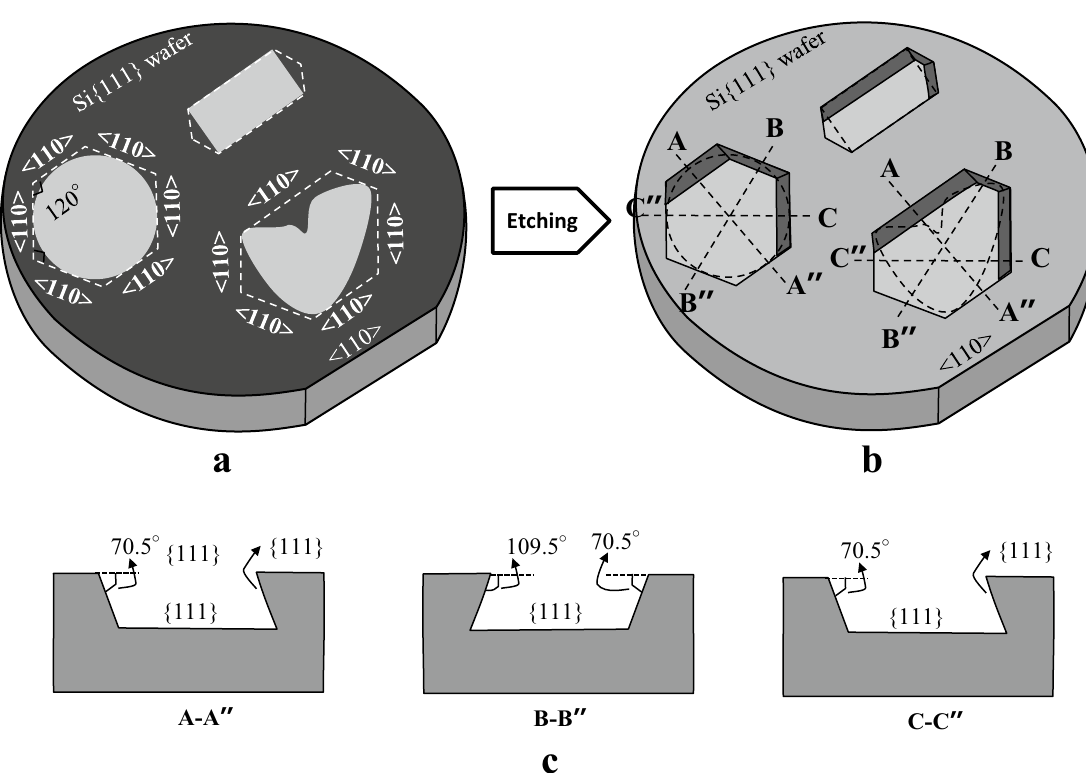
Fig. 2 Schematic representation of the wet anisotropically etched profiles of different shapes mask geometries on Si{111} wafer: a mask pattern on wafer surface, b etched profile after wet anisotropic etching, and c cross sectional view of etched profiles. Dashed lines in a indicate the directions where wet etch will terminate due to the appearance of {111} planes